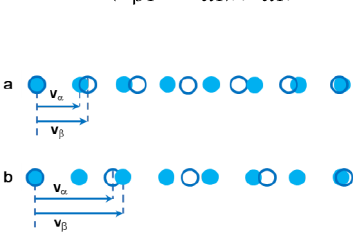
Figure 3. The misfit along a row direction, ( a ) with one-to-one correspondence, ( b ) with one-to- x correspondence. The filled circles are atoms in one phase and the open circles are those in the other phase. The arrows point to the correspondence.